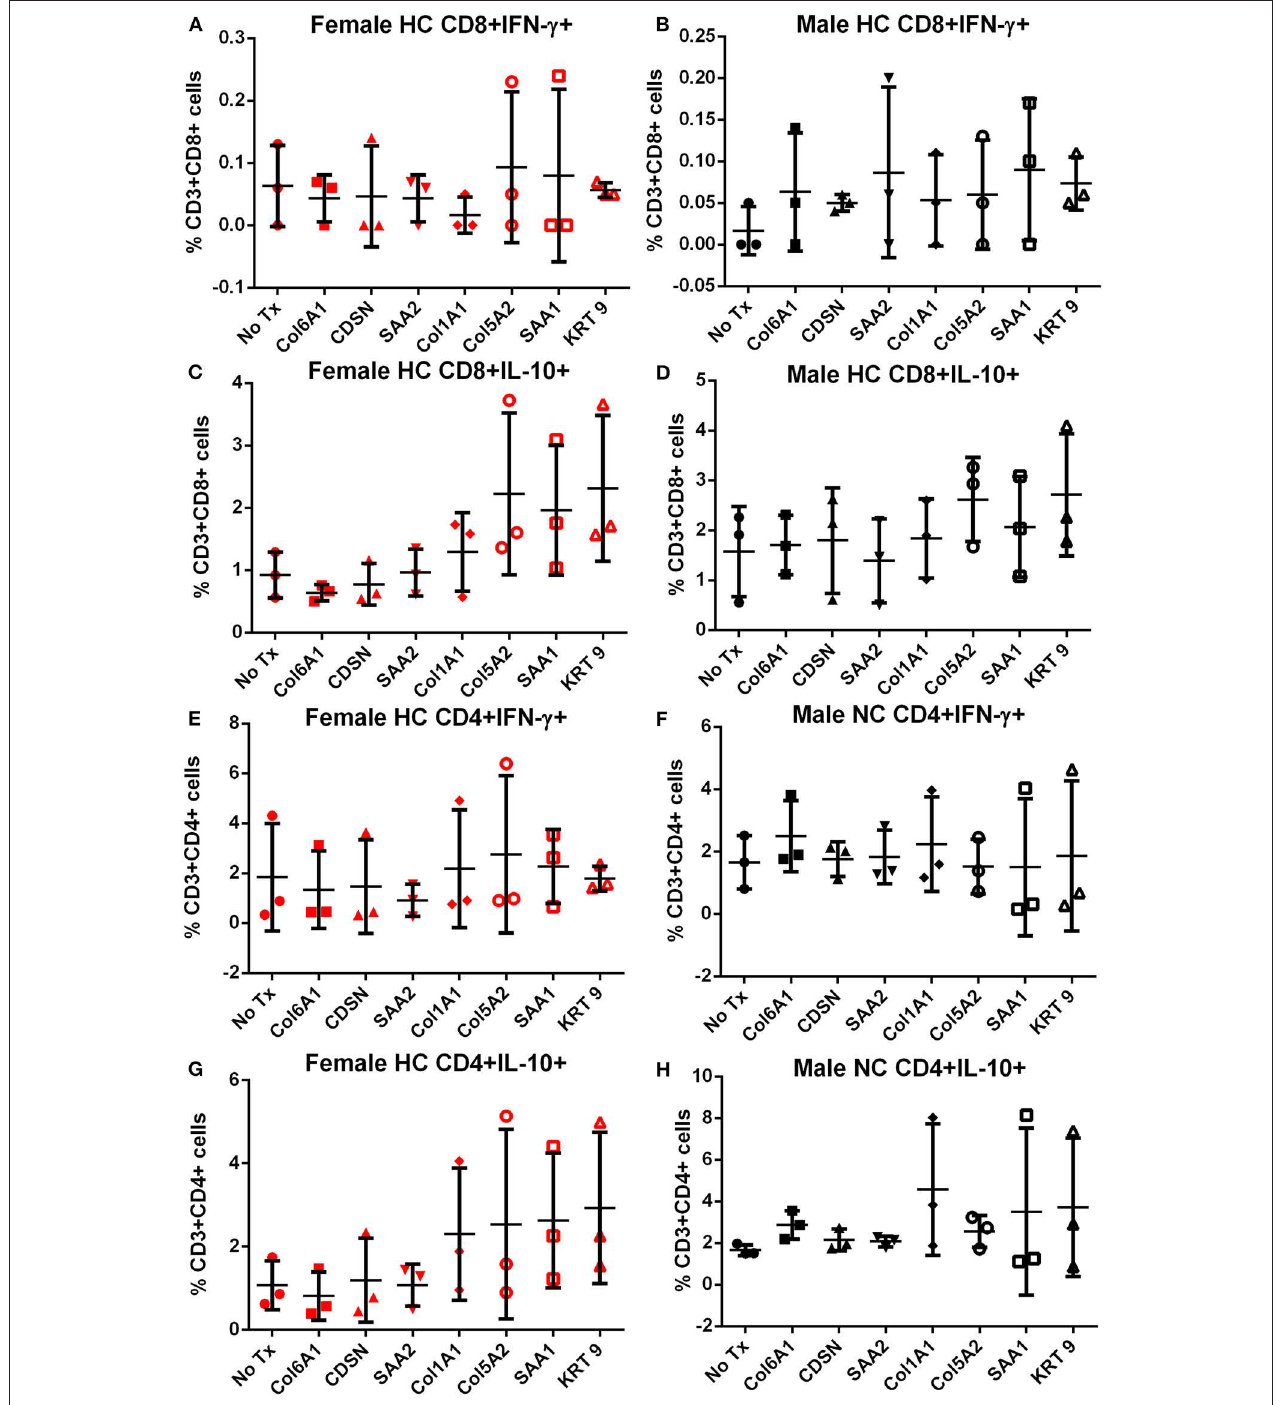
FIGURE 3 | Intracellular cytokine staining of splenocytes from mice fed with high fat diet. Splenocytes from female (A,C,E,G) or male (B,D,F,H) apoE–/– mice fed high fat diet (HC) stimulated for 6h with mouse homologs of self-peptides selected from patient immune peptidome and stained for intracellular IFN- γ and IL-10. N = 3 each. Gating scheme in Figure S1